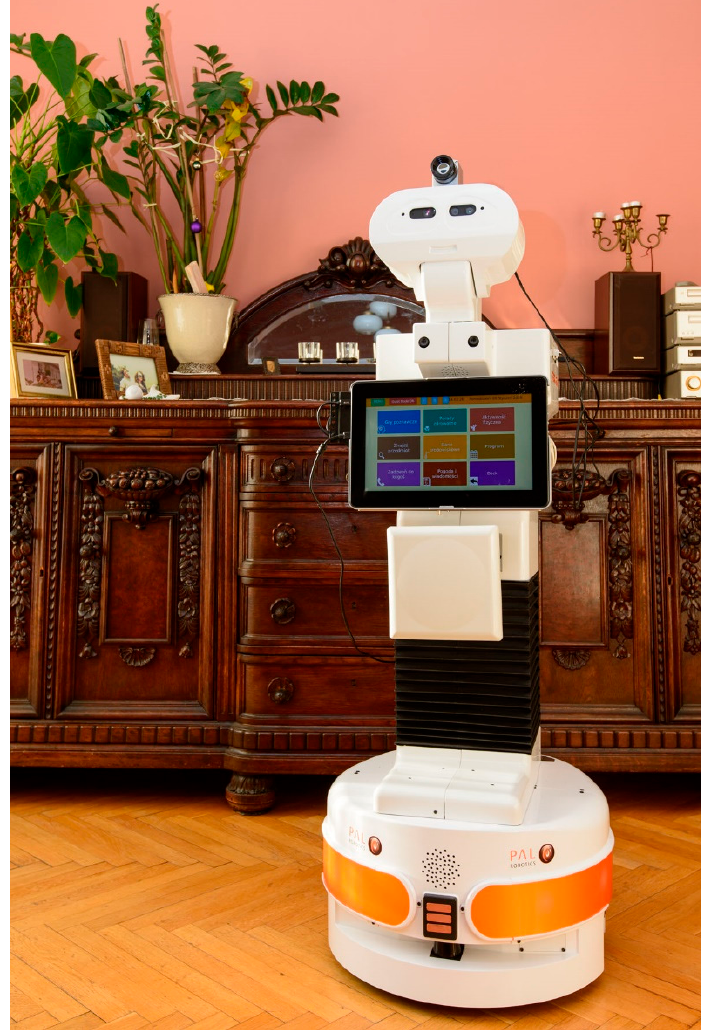
Figure 1. The TIAGo robot.